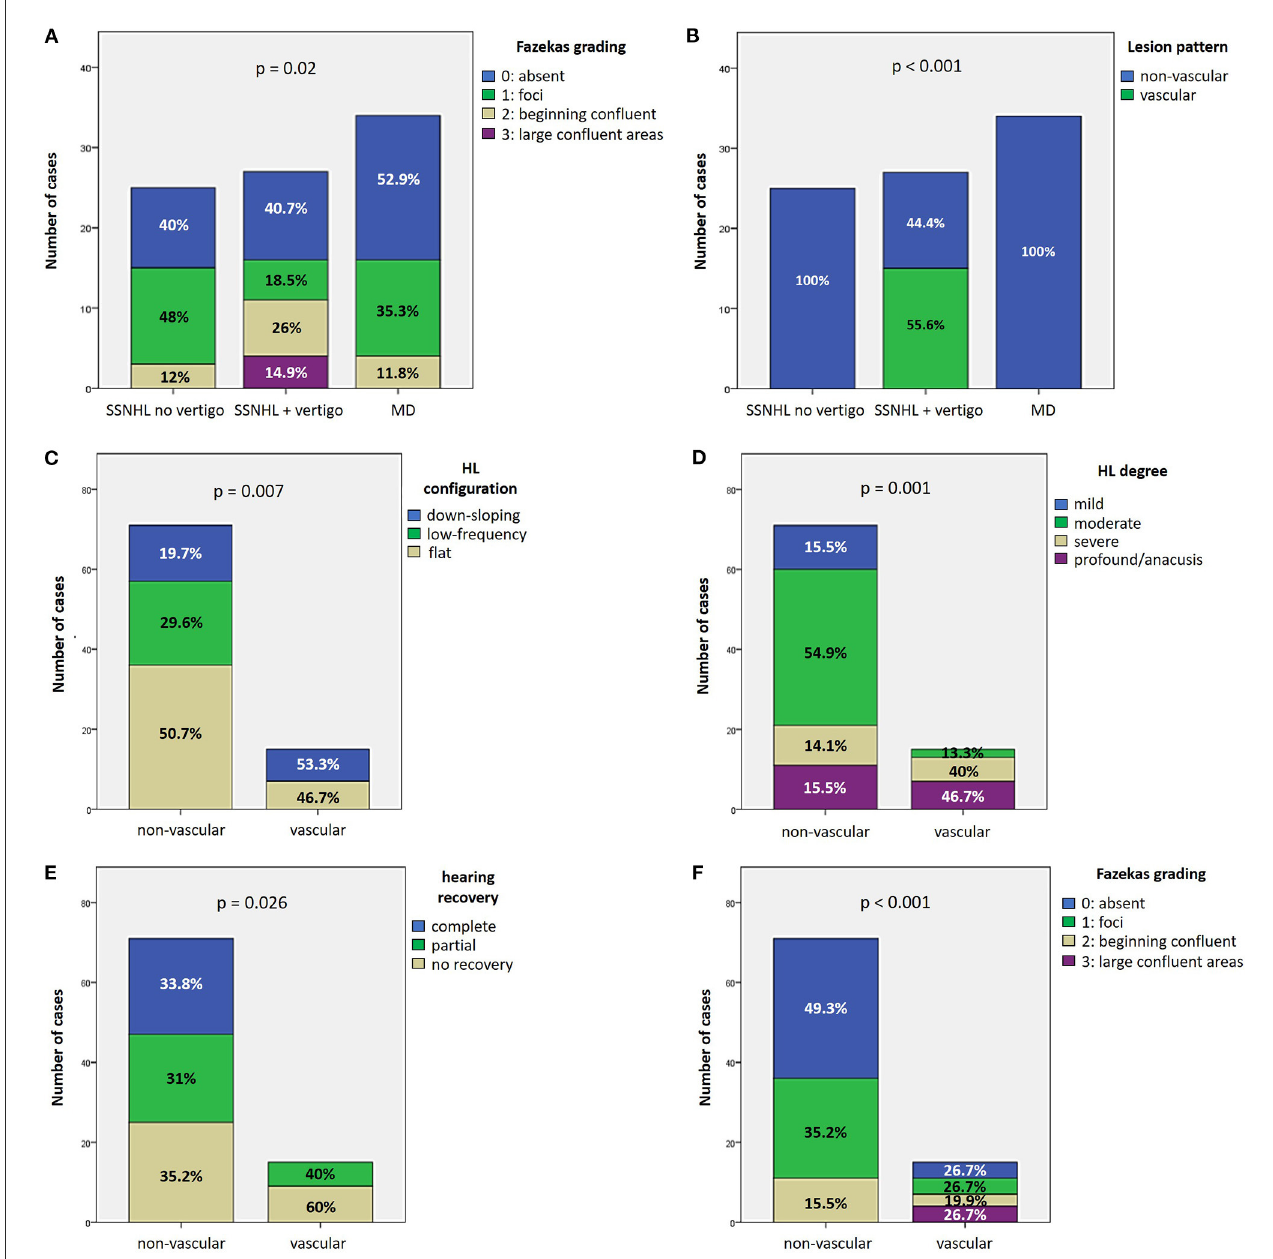
FIGURE10 Vascular patterns. (A, B) Bar plots showing the different distribution of Fazekas grading of WML on MRI (A) and instrumental lesion patterns consistent with a vascular lesion (B) among the study cohort divided according to the clinical course. (C–F) Bar plots showing the different distribution of HL configuration (C) , HL degree (D) , hearing recovery (E) , and Fazekas grading of WML on MRI (F) among the study cohort divided according to the instrumental lesion patterns consistent with a vascular lesion. Relative percentages are reported in each column and p -value of categorical